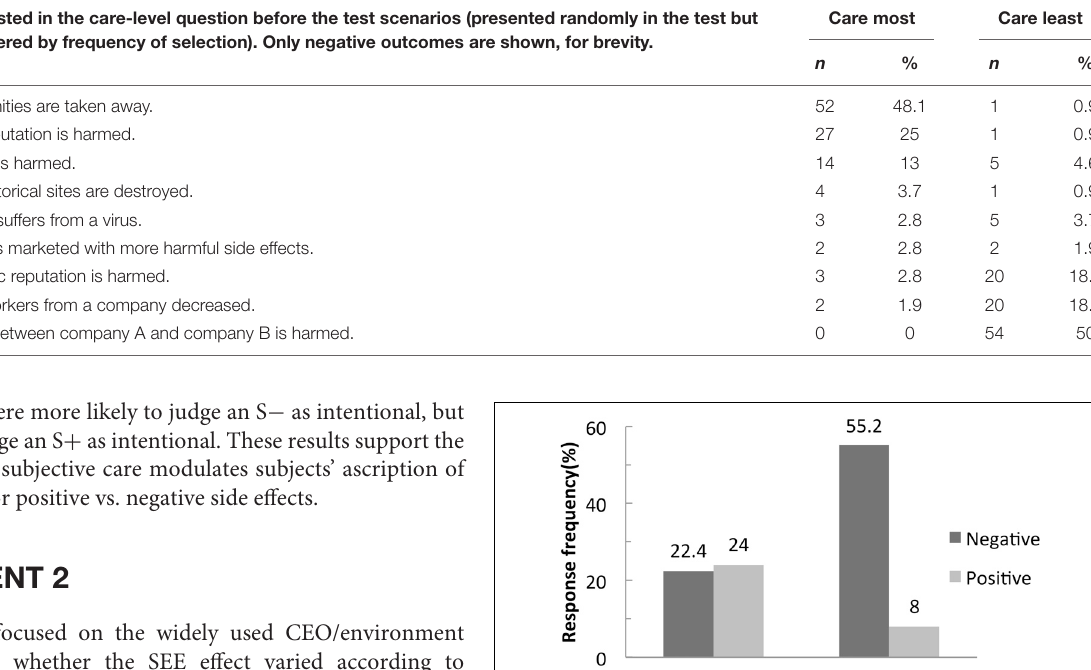
TABLE 1 | Summary of frequencies for selecting high- and low-care events.